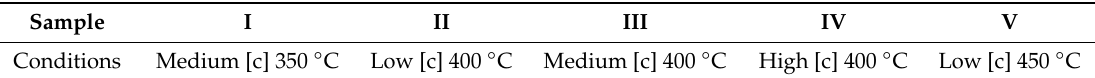
Table 1. Precursor concentration [c] and decomposition temperature of the